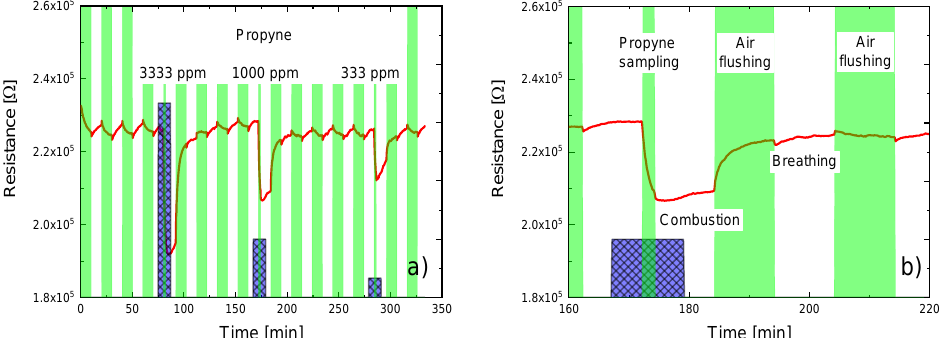
Figure 6. ( a ) (Green bars) timing of flow and no-flow periods of the EMRS; (blue bars) timing of propyne admixtures in the bypass line. Red line: reaction of MOX sensor resistance to pump-on and pump-off cycles and to gas sampling events; ( b ) Detail view onto the MOX sensor variation before, during and after a typical gas sampling event.